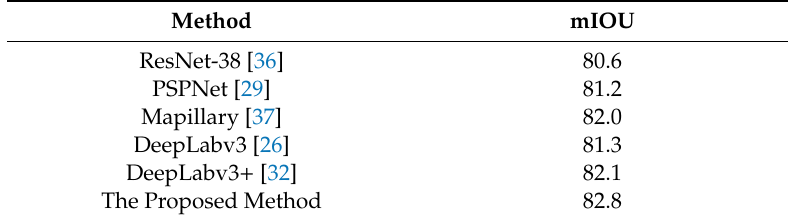
Table 1. Results of accuracy (mIOU) for the proposed method and methods from the literature on images in the Cityscapes database.